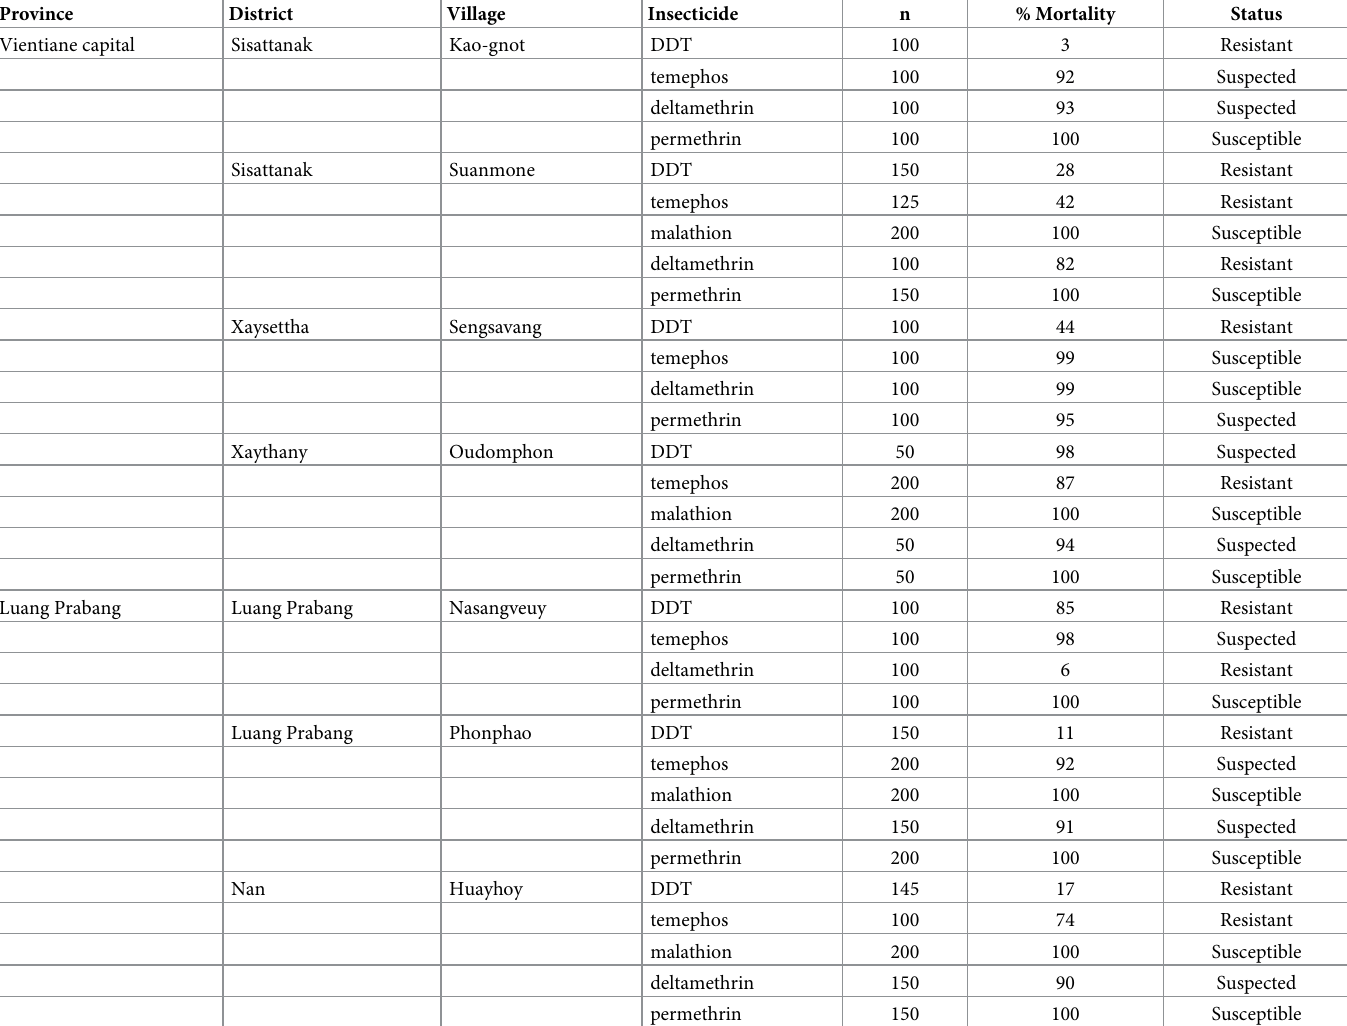
Table 3. Resistance status of Aedes albopictus larvae against DDT, temephos, malathion, deltamethrin and permethrin. Province